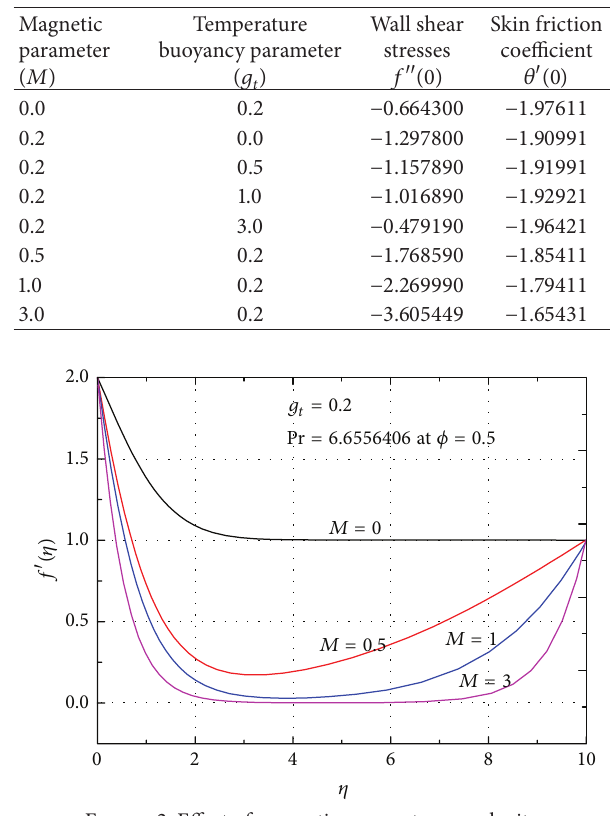
Figure 2: Effect of magnetic parameter on